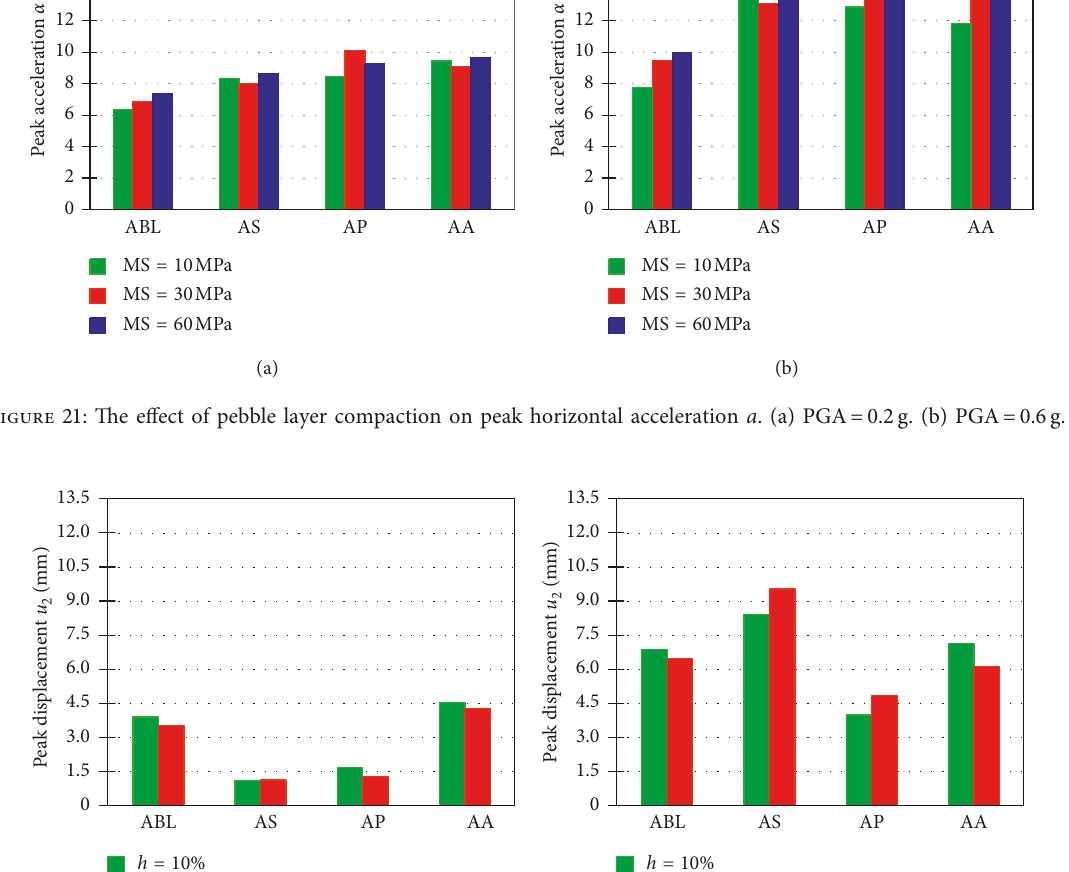
� 0.2g. (b) PGA � 0.6 g. 2 . (a) PGA